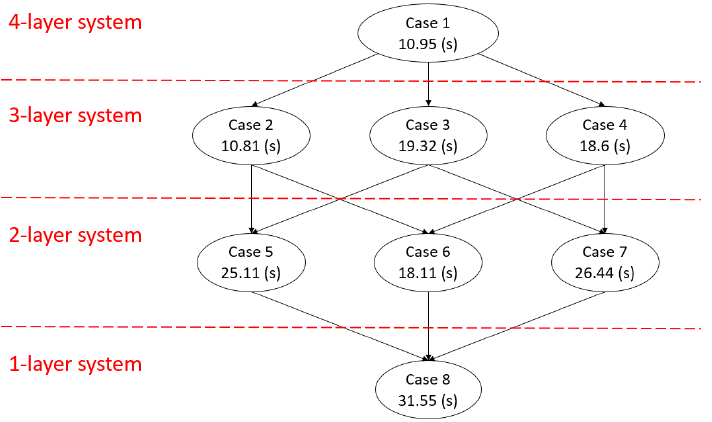
Figure 7. The weighted average of system fault detection time for all cases and the fault model switching